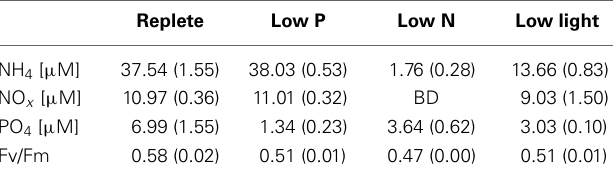
Table 1 | Nutrient concentrations in the culture media and cellular photosynthetic efficiency (Fv/Fm) at the time of